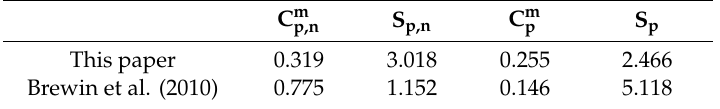
Table 4. Regionally tuned and default parameters of the three-component model. C m p,n S